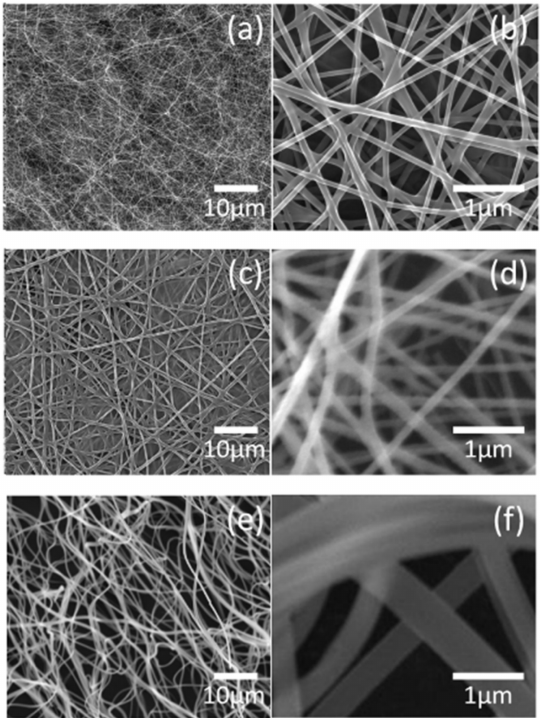
Figure 6. FE-SEM images of calcined Ni 0.5 Zn 0.5 Fe 2 O 4 nanofibers obtained from precursor solution 15-A ( a ) low magnification, ( b ) high magnification, Calcined Ni 0.5 Zn 0.5 Fe 2 O 4 nanofibers obtained from precursor solution 15-B ( c ) low magnification, ( d ) high magnification, and Calcined Ni 0.5 Zn 0.5 Fe 2 O 4 nanofibers obtained from precursor solution 15-C ( e ) low magnification, ( f ) high magnification.